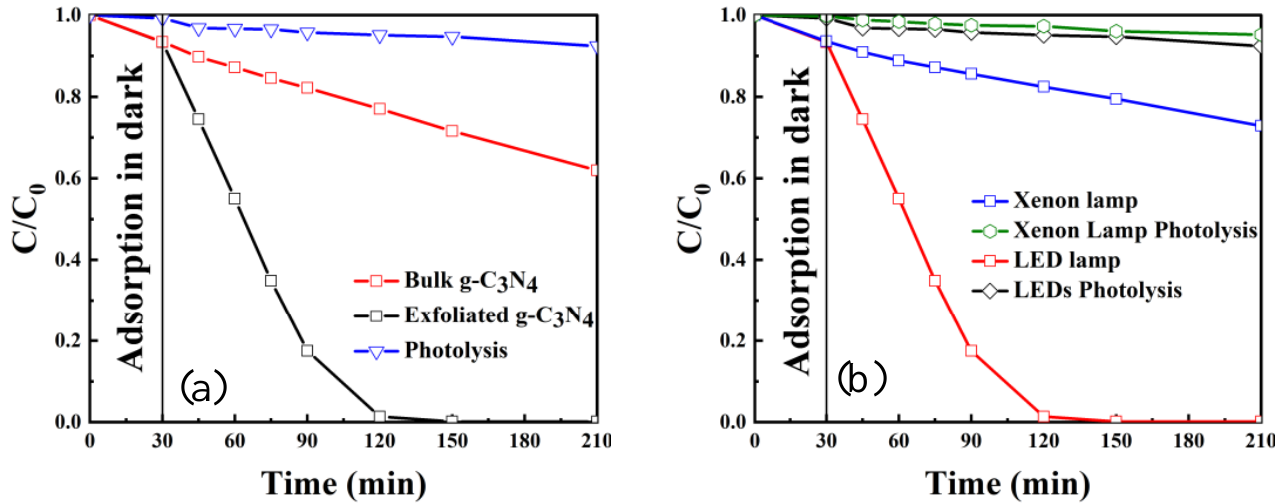
Figure 6. Phenol degradation with ( a ) bulk and exfoliated g-C 3 N 4 ( b ) as a function of the light source; C 0 = 20 ppm, airflow = 50 mL/min, catalyst concentration = 0.5 g/L, pH = natural.